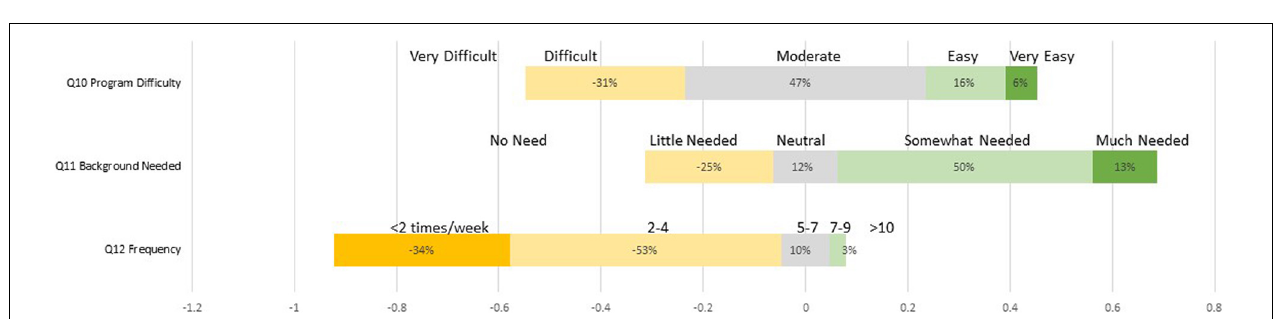
FIGURE 1 | The percentage of ratings on item 1 to item 9 in program evaluation survey.